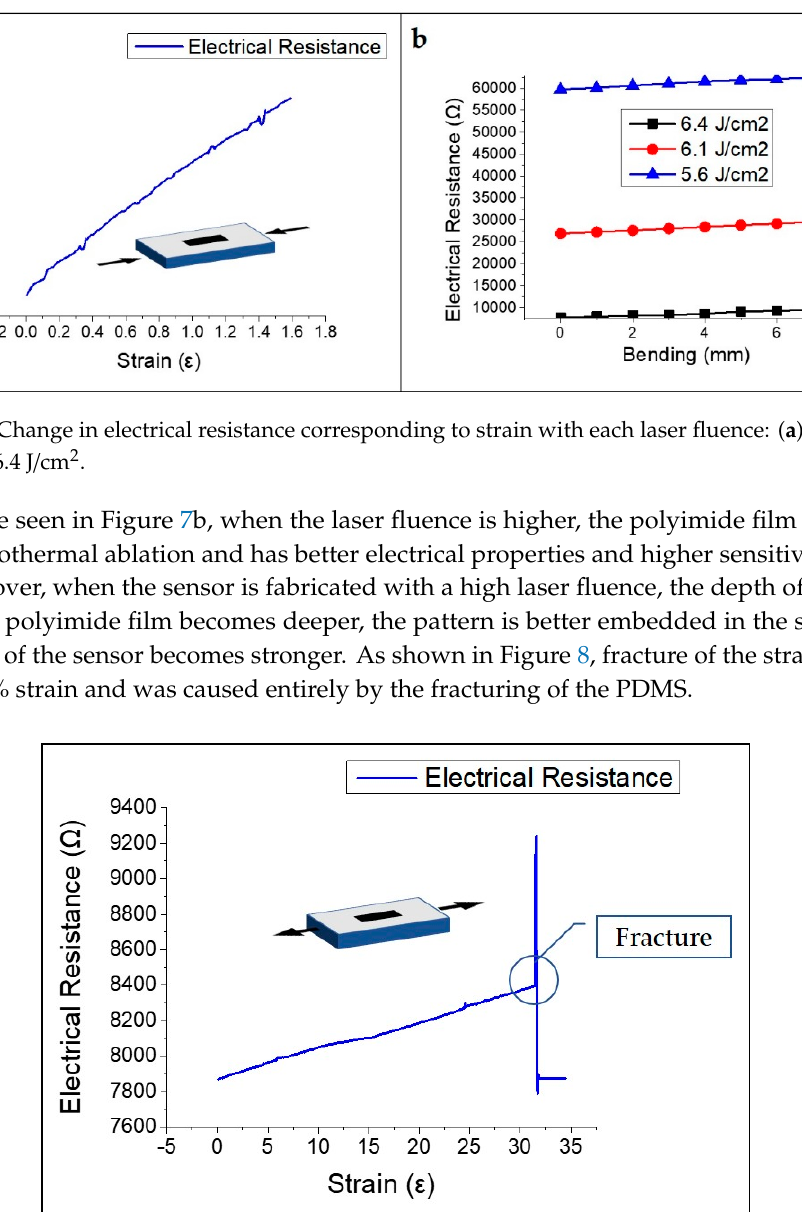
Figure 9. ( a ) Electrical response of LIG strain sensor; ( b ) Change of initial electrical resistance according to focal length.